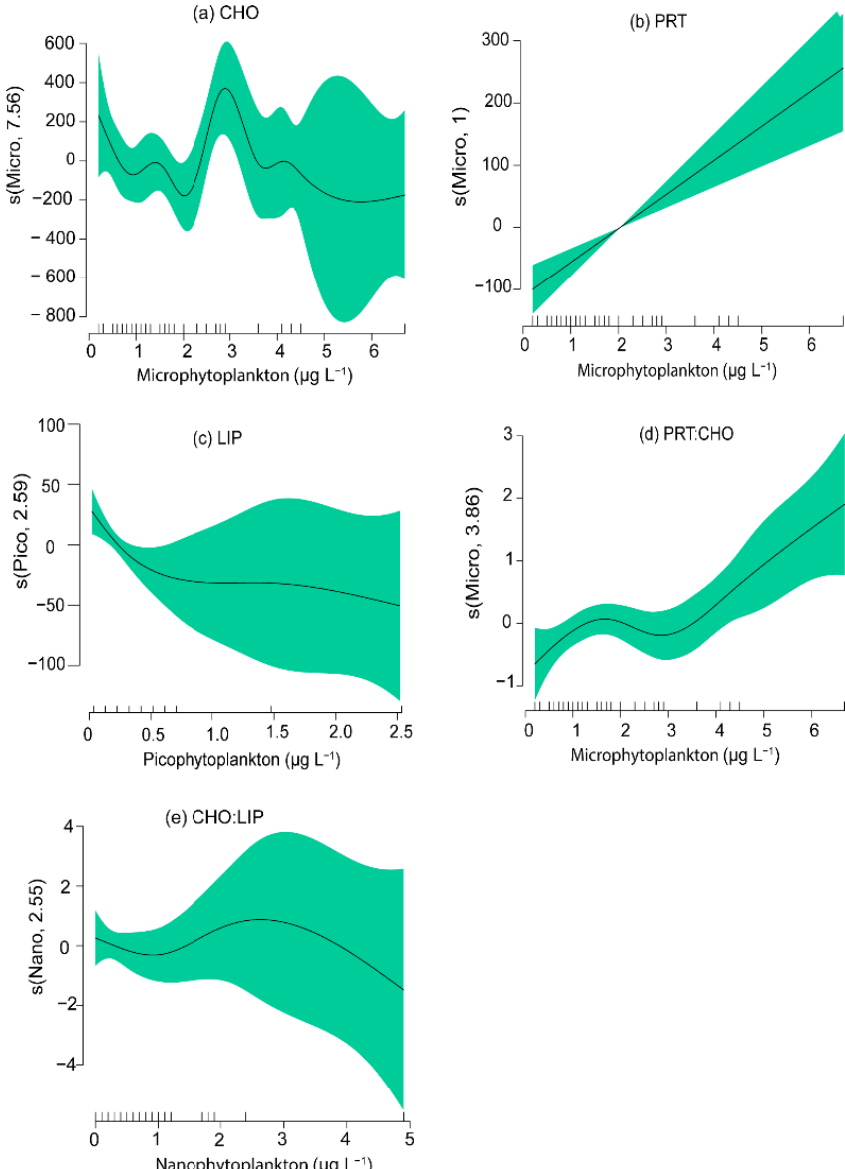
Figure 7. Generalized additive models (GAMs) best fitted to the biochemical characteristics of seston and phytoplankton size groups ( a – e ). Statistically significant ( p < 0.05) relationships are indicated by solid lines, with shaded areas representing the 95% pointwise confidence intervals.